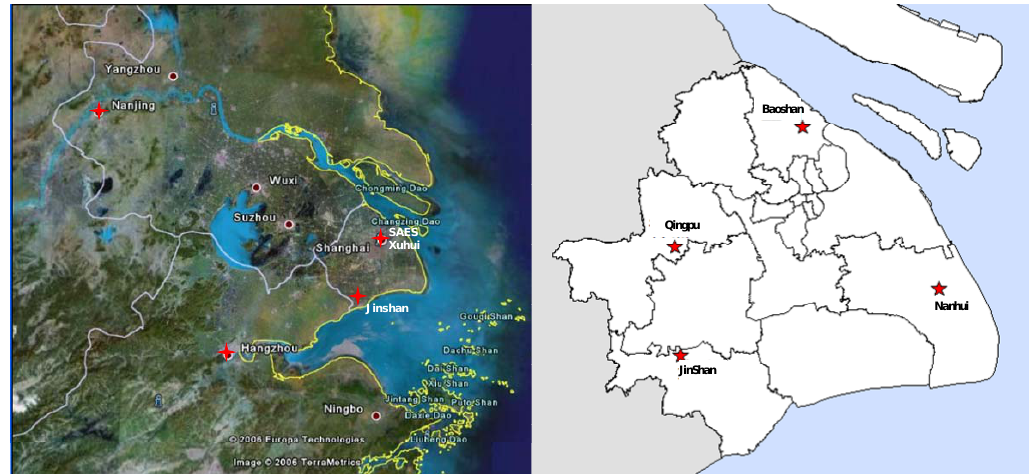
Fig.5. Locations selected to do O process analysis (left) and meteorological stations to do MM5 Fig. 5. Locations selected to do O 3 process analysis (left) and meteorological stations to do MM5 model evaluation (right) in the YRD. 3 model evaluation (right) in the YRD into gridded meteorological field data as the input to